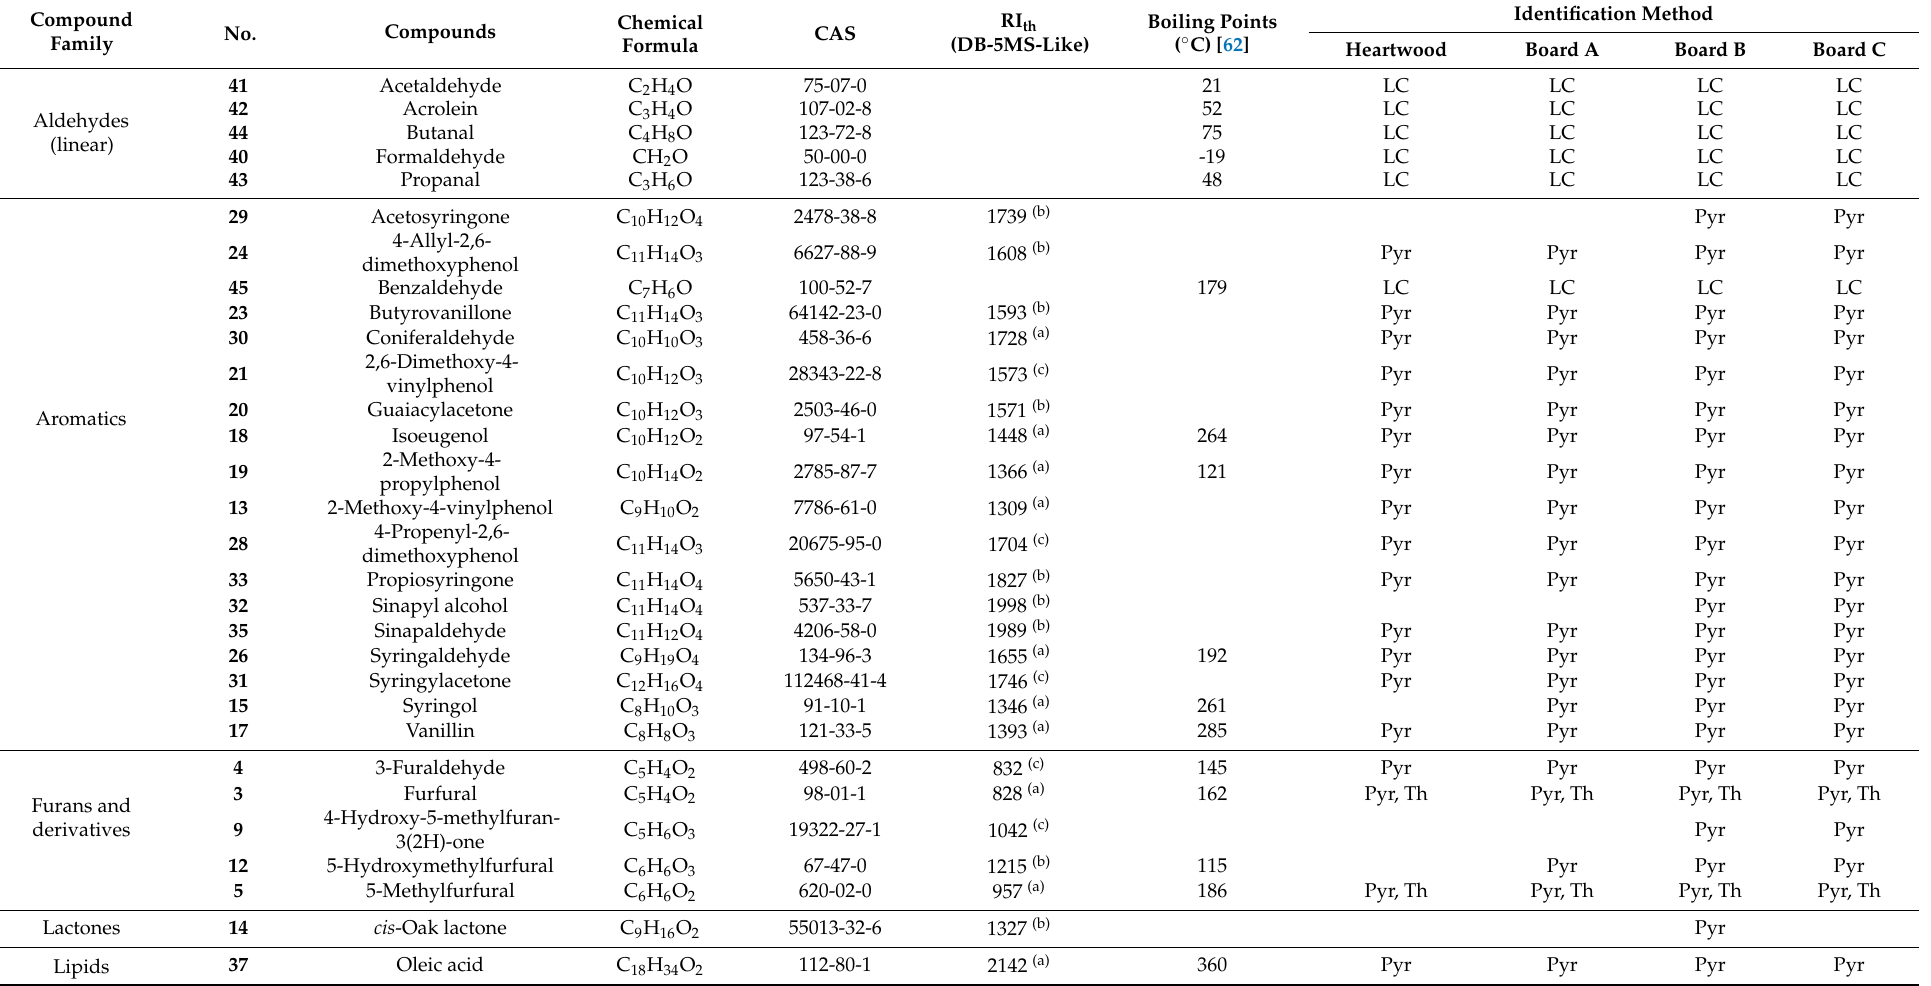
Table 3. List of tentatively identified compounds by thermal extraction of the different materials